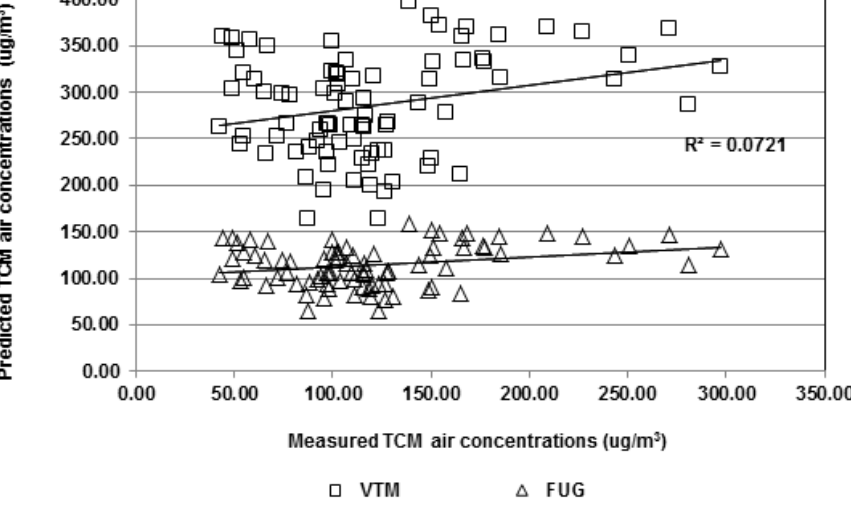
Table 7. Means of square residuals between measured and predicted TCM air